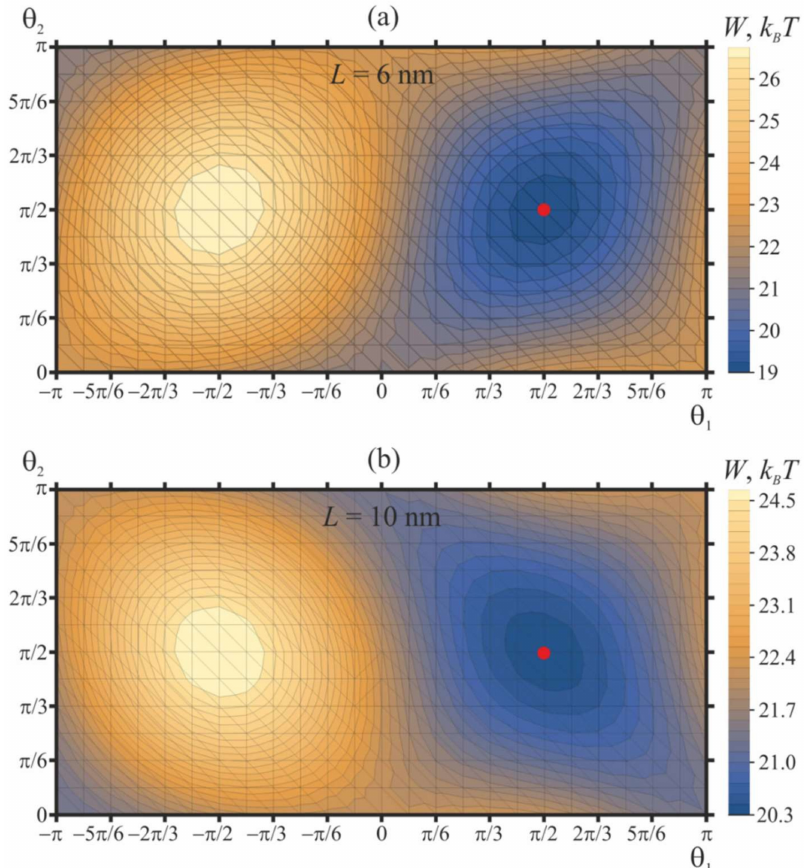
Figure 4. Dependence of membrane elastic energy on the orientation angles of two free peptide trimers separated by ( a ) 6 nm; ( b ) 10 nm. The minimum of the elastic energy (marked by red circle) is at θ 1 = θ = π / 2 independent of protein 2